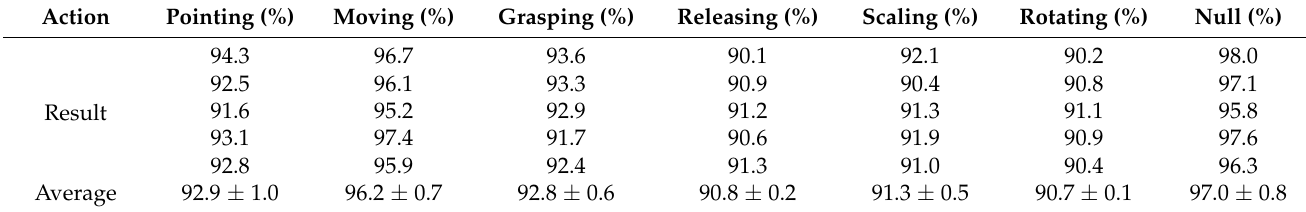
Table 3. The recognition accuracy on Assembly Gesture Video Dataset.